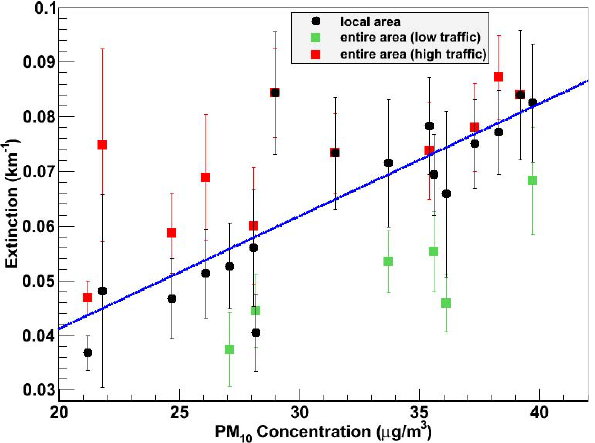
Fig. 7. Temporal evolution of LIDAR-derived aerosol extinc- tion coefficients over the entire scanning area (with point sources excluded), 200m above the town from 09:00 to 16:00CET on 24 May 2010 and from 09:00 to 18:00CET on 25 May 2010.